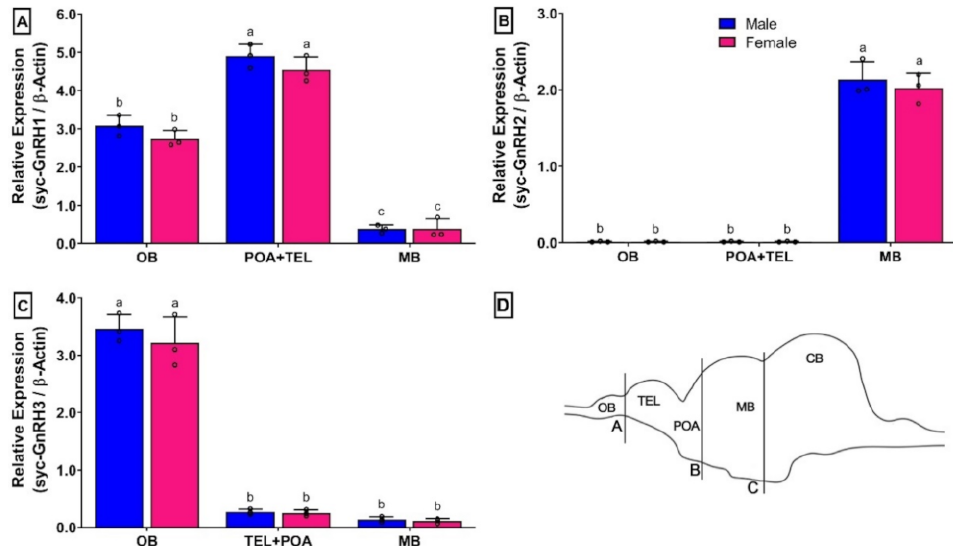
Figure 6. Relative mRNA expression levels (2 − ∆∆ CT ) of three GnRH isoforms in different brain areas of small yellow croaker detected by qRT-PCR: ( A ) syc-GnRH1, ( B ) syc-GnRH2, and ( C ) syc-GnRH3, and ( D ) schematic diagram of brain part. For all bar graphs, raw data points (black circle) represent biological replicates, error bars represent standard deviation, and different letters above the bars indicate significant differences ( p < 0.05) among organs. OB, olfactory bulb; TEL, telencephalon; POA, preoptic area; MB,